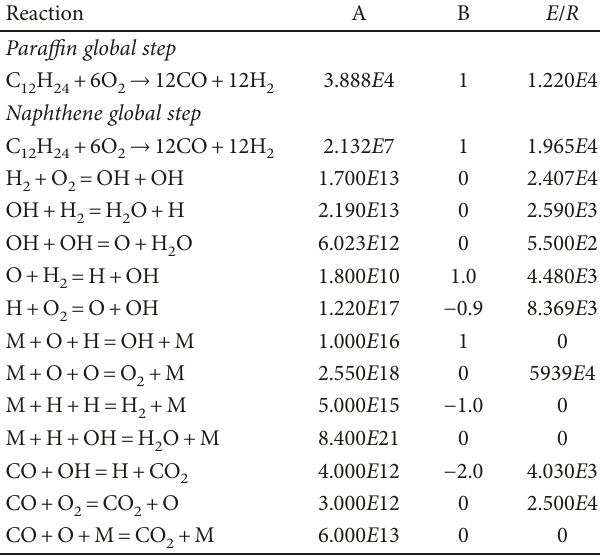
Table 2: Multistep chemical